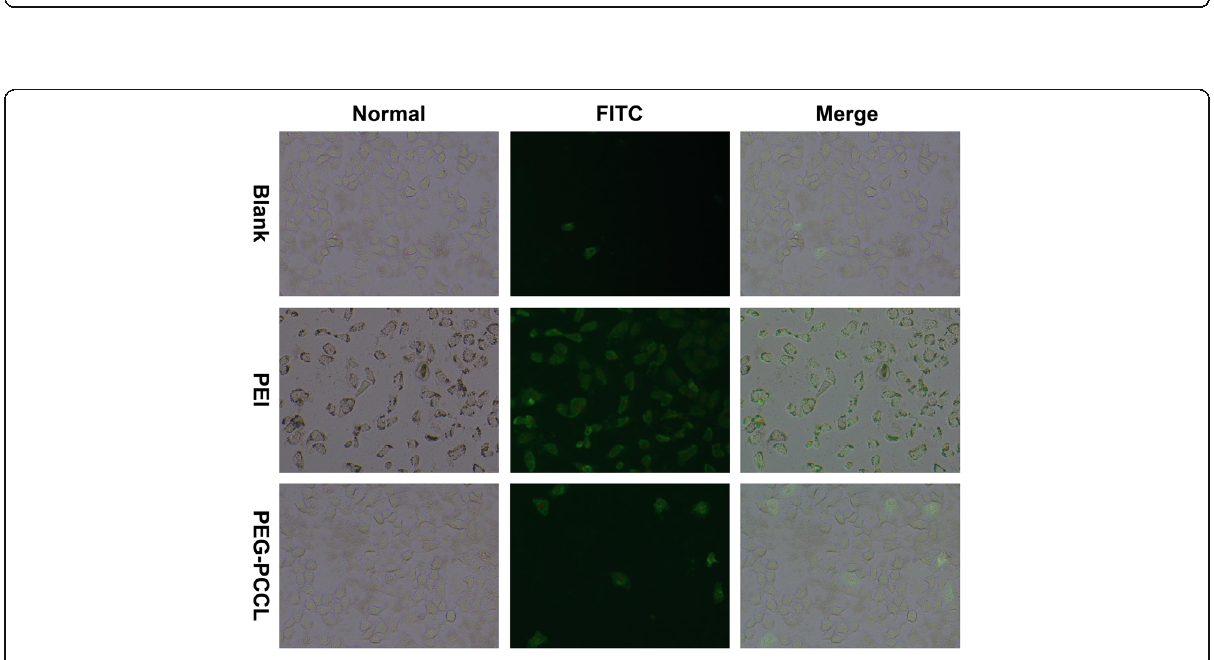
Fig. 4 Electron micrographs. a , b Normal HepG2 cells. c , d Cells treated with PEG-PCCL nanoparticles through SEM (scanning electron microscope). The dark arrow points at the pinocytotic